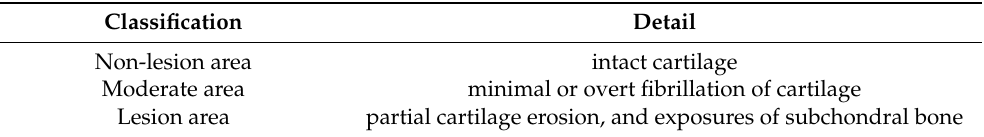
Table 3. Articular cartilage degeneration